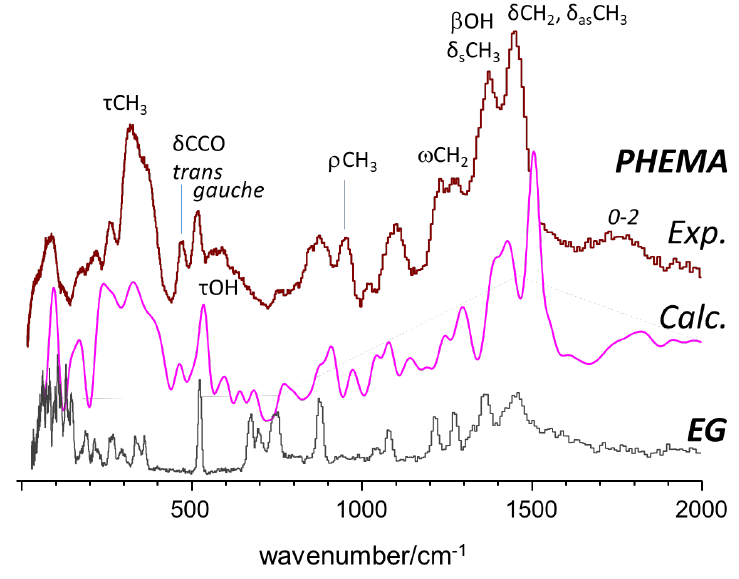
Figure 3. INS spectra of PHEMA in the 20–2000 cm − 1 range (top), compared with the calculated spectra generated from identical contributions of heterotactic and syndiotactic triads (middle), and the INS spectrum of ethylene glycol (bottom) [36] (arbitrary intensity units).